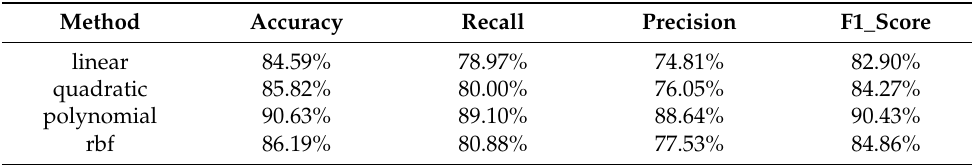
Table 3. Training results without Feature Selection on balanced data.